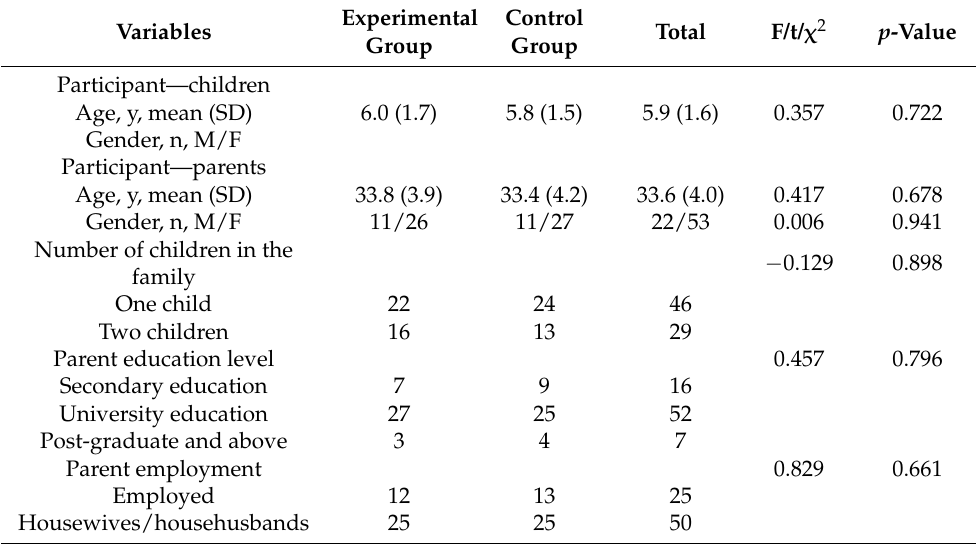
Table 1. Demographic data of the